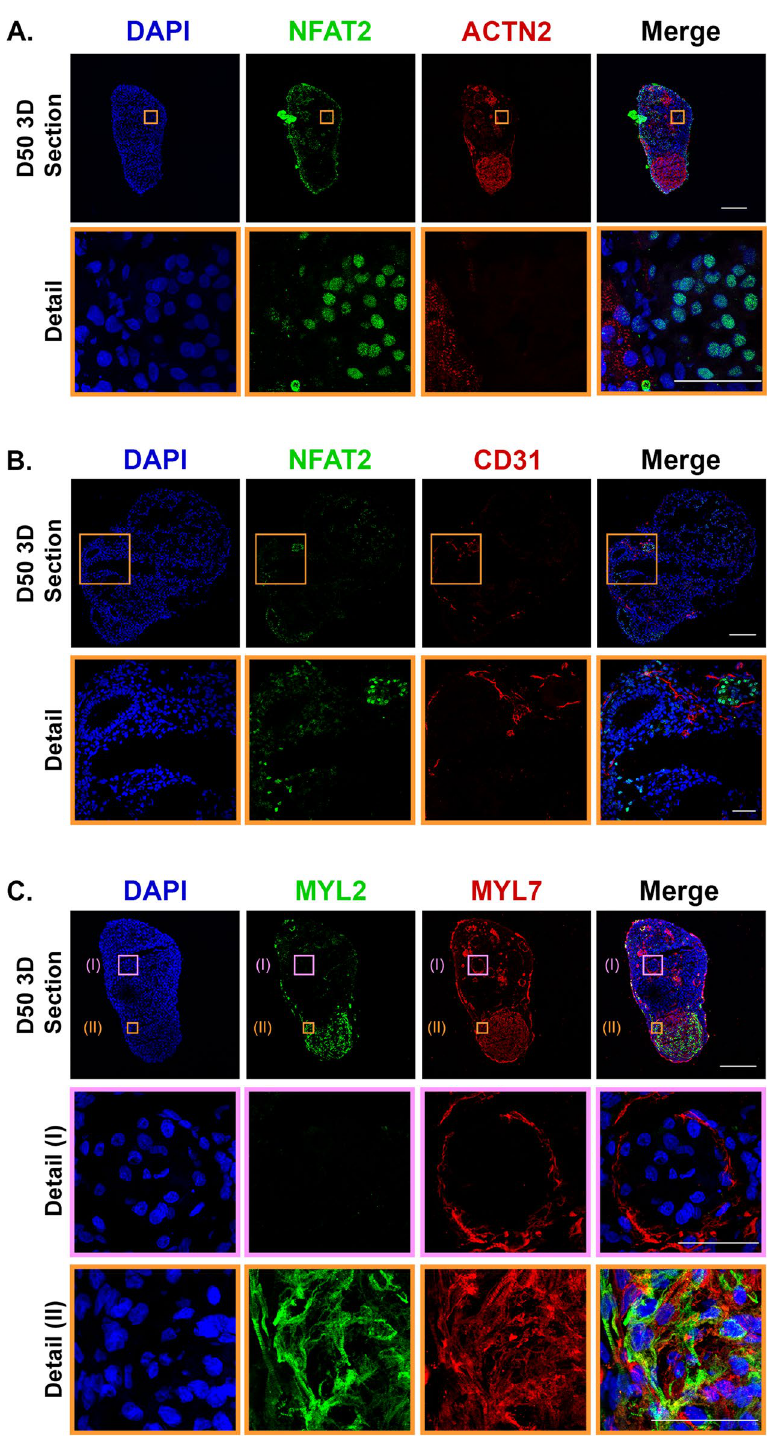
Figure 4. Long-term 3D culture of hOCMTs recapitulates advanced cardiac morphology and cellular heterogeneity in vitro showing markers for endocardial, endothelial, and cardiomyocyte subtypes. Immunofluorescence analysis showing the representative co-specification of multiple cell type markers in 3D hiPSCs-derived cardiac microtissue/hOCMT sections on day 50 including endocardial ([ A , B ] NFAT2 in green), endothelial cells ([ B ] CD31 in red), pan-cardiomyocytes ([ A] ACTN2 in red), atrial ([ C ] MYL7 in green) and ventricular ([ C ] MYL2 in red) cardiomyocyte subtypes. Nuclei were counterstained with DAPI (blue). Full 3D hOCMTs scale bar = 200 µm, Close-up scale bar = 50